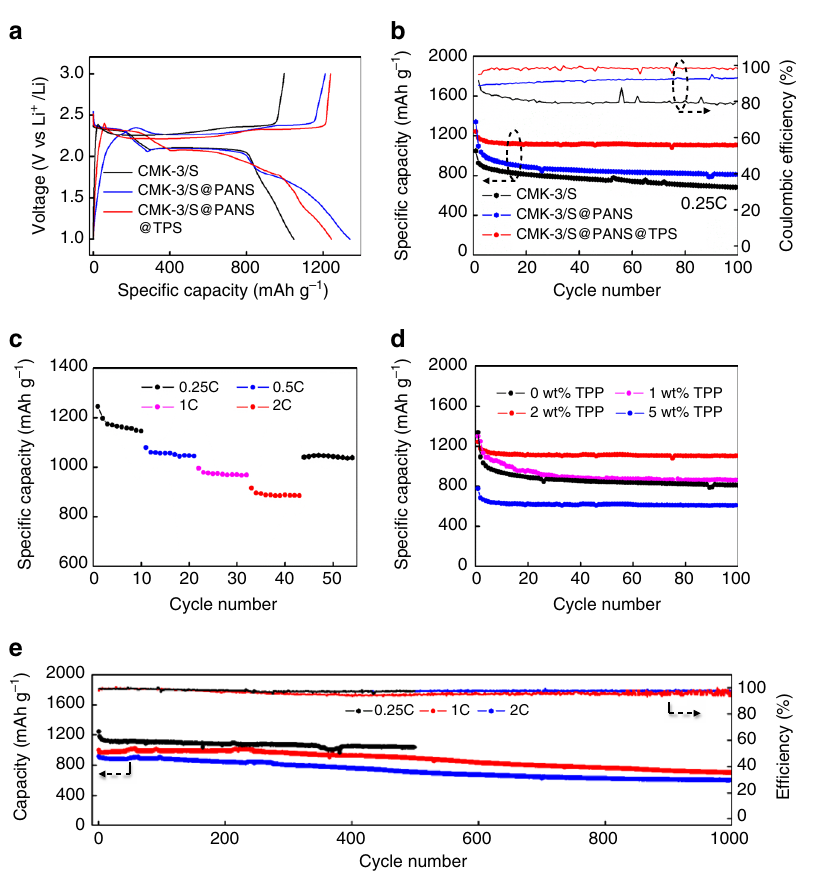
Fig. 3 Electrochemical performance of the lithium – sulfur batteries. a Initial galvanostatic cyclic curve of CMK-3/S, CMK-3/S@PANS, and CMK-3/ S@PANS@TPS cathodes. b Cycling performance of CMK-3/S, CMK-3/S@PANS, CMK-3/S@PANS@TPS cathodes at 0.25 C (1 C = 1672 mA g − 1 ). c Rate performance of the CMK-3/S@PANS@TPS cathode. d Cycling performance of CMK-3/S@PANS@TPS cathode with various TPP contents in the electrolyte at 0.25 C. e Extended cycling performance of CMK-3/S@PANS@TPS cathodes at 0.25 C, 1 C, and 2